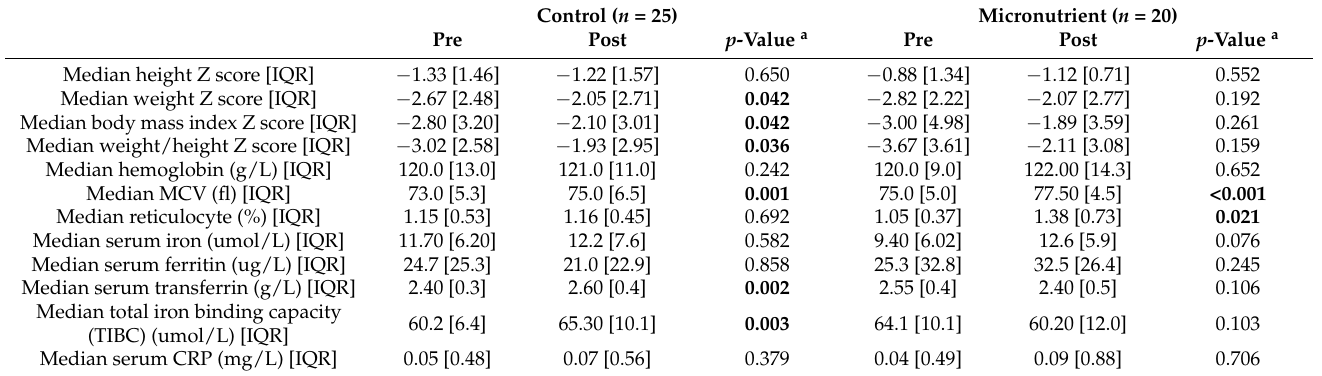
Table 4. Comparisons of trial endpoints before and after administrations of interventions in each treatment arm ( n =